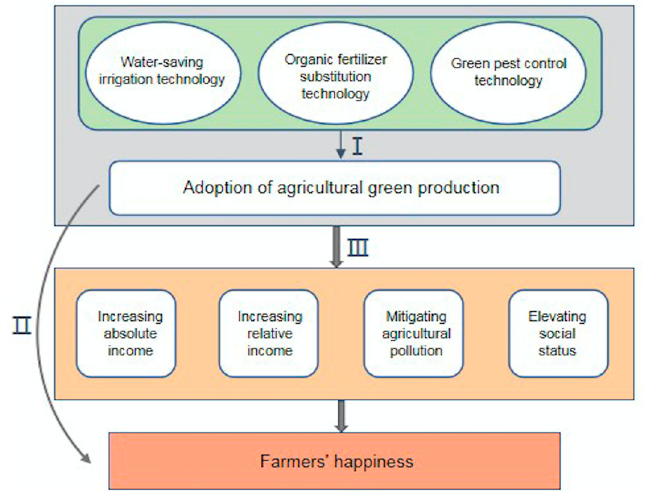
Figure 1. Theoretical model of the study. I represents the three component dimensions of agricultural green production. II represents the direct effect of adopting agricultural green production on farmers’ happiness. III represents the mediation effect of adopting agricultural green production on farmers’ happiness. The light orange color represents the four mediating variables.